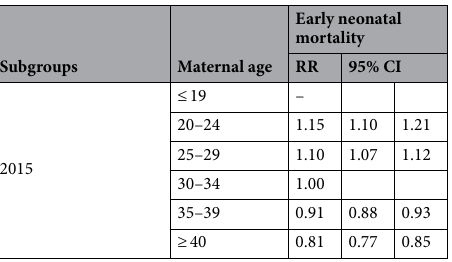
Table 3. Risk ratios (RR) (95% CI) for neonatal mortality according to